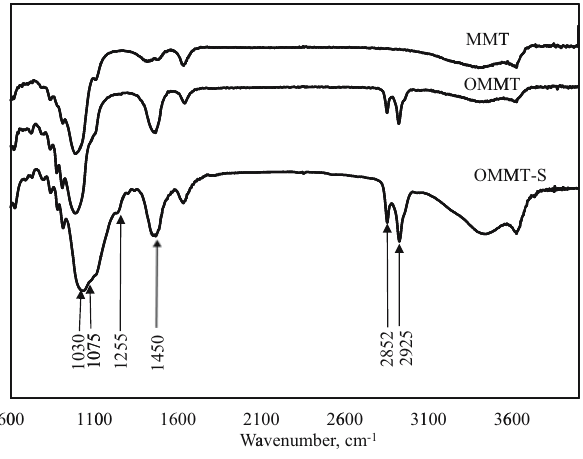
Figure 1: FTIR spectra of MMT, OMMT and OMMT -